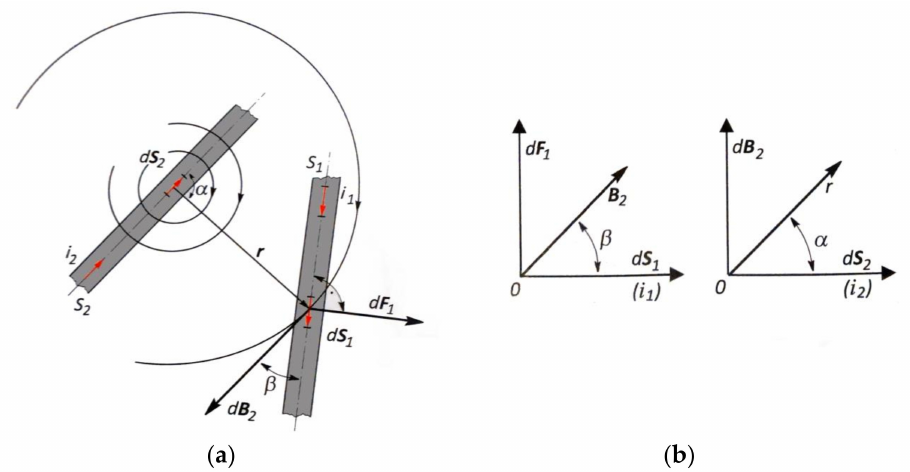
Figure 1. Determination of electrodynamic force value acting on the busbar. ( a ) the method of determining the direction and sense of magnetic induction; ( b ) Biot-Savart